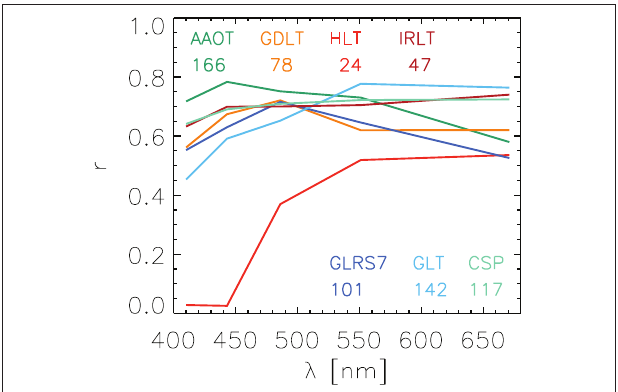
FIGURE 8 | Spectra of correlation coefficient between residuals of VIIRS SNPP and JPSS1 (i.e., differences with respect to PRS field data) computed with common